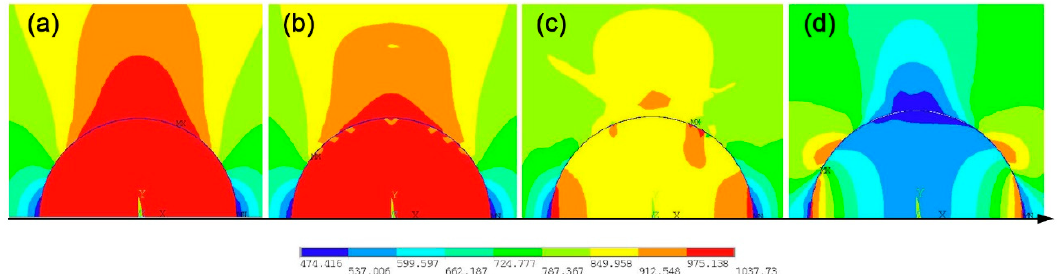
Figure 11. Interface stress field evolution of specimen No. 1: ( a ) before crack initiation, ( b ) crack initiation stage, ( c ) crack propagation stage, ( d ) complete debonding of the interface.